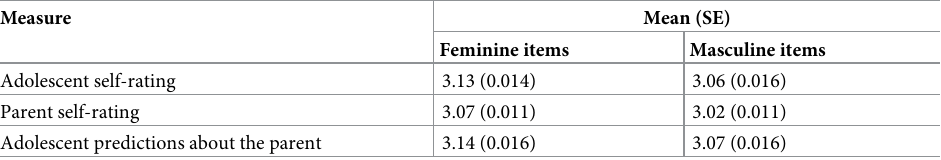
Table 4. Means and standard errors of stereotype endorsement on feminine and masculine items of the trait sub- scale of the